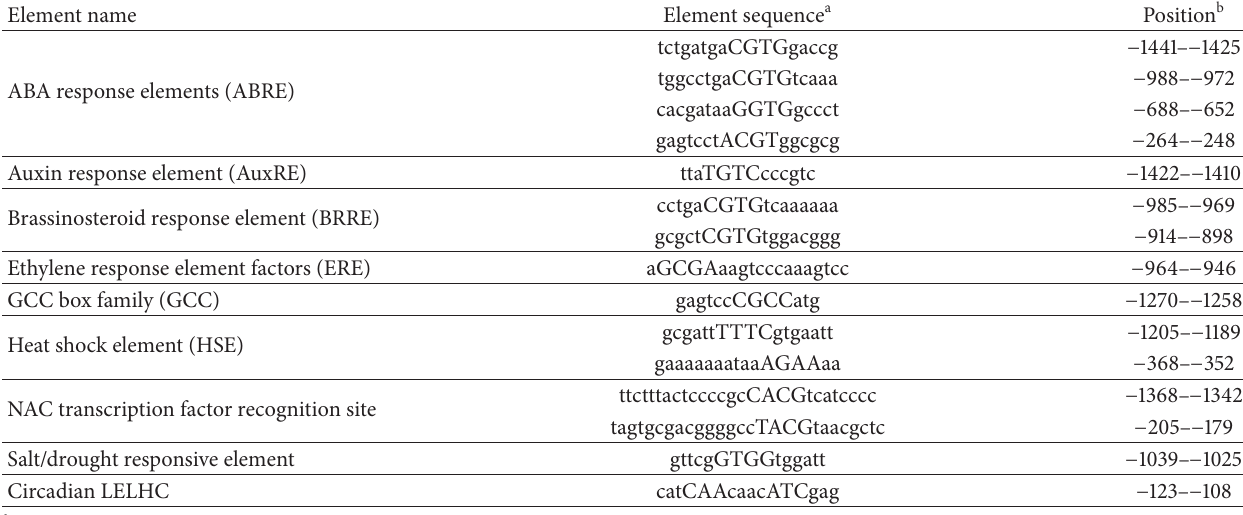
Table 1: Predicted cis- elements in the promoter region of CMYB1 .